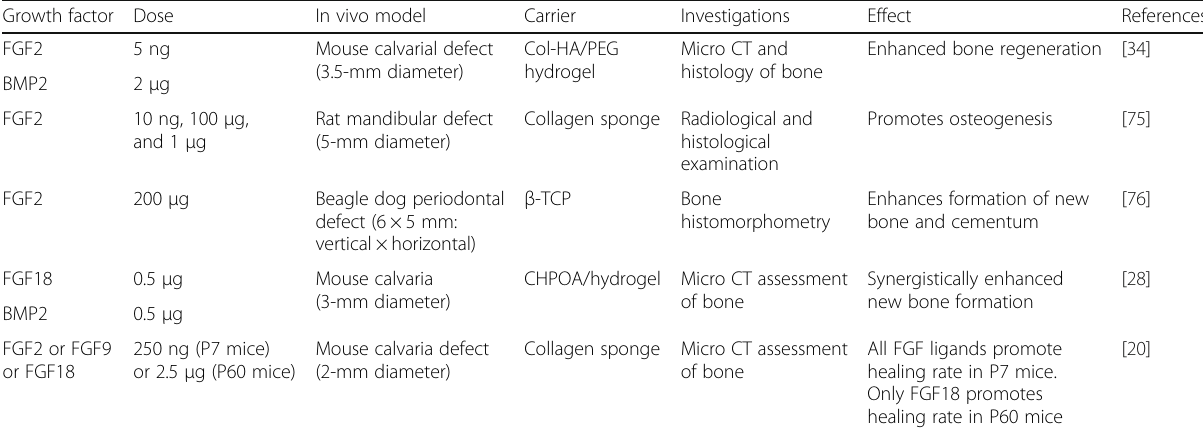
Table 3 Application of different FGFs in critical-sized bone defect in vivo models Growth factor